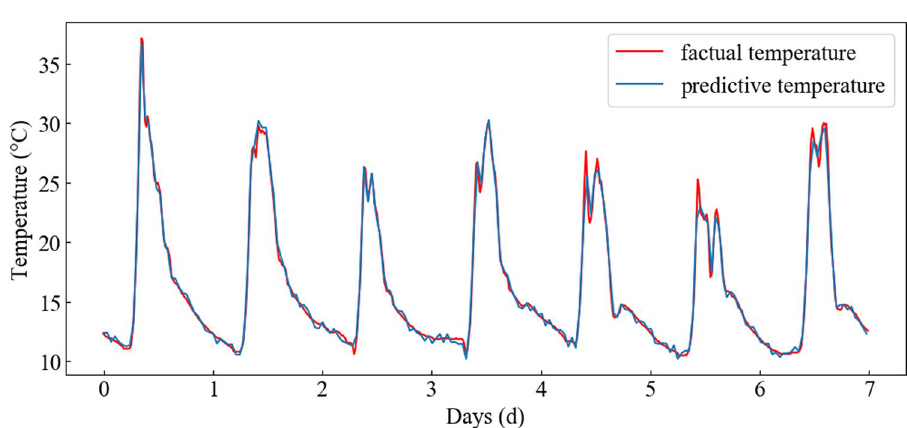
Figure 10. Temperature prediction